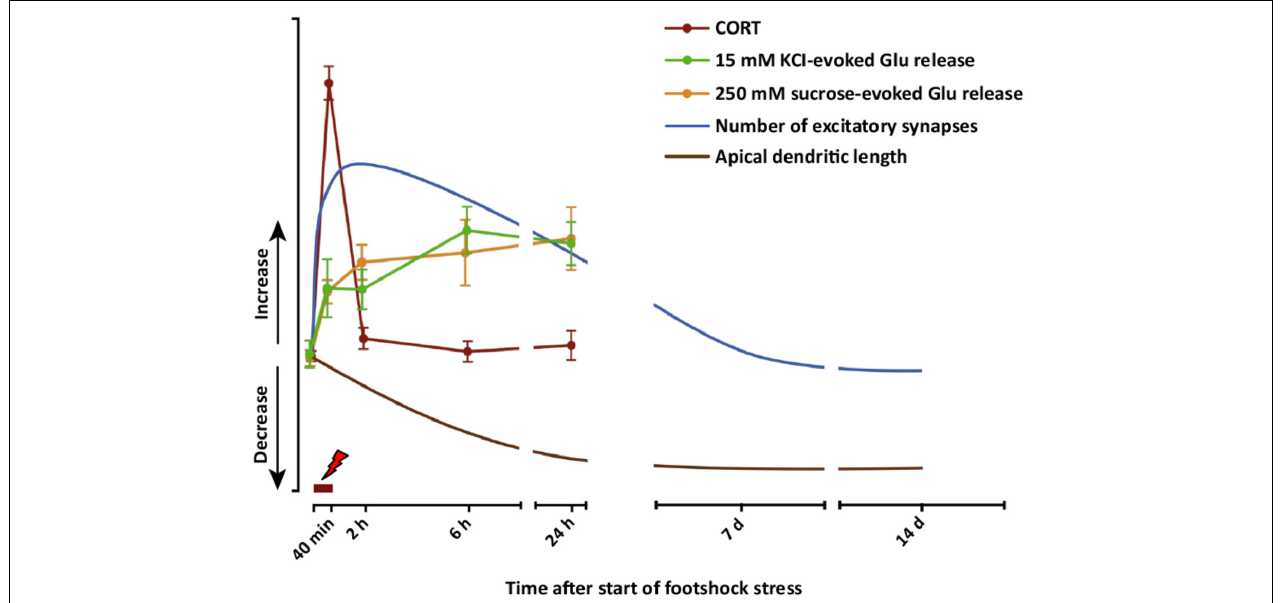
FIGURE 4 | Graphic summary of short- and long-term functional and neuroarchitectural effects in prefrontal cortex (PFC) synapses after acute FS stress. The fast and transient increase in CORT release induced by acute FS stress was accompanied by the rapid increase in both depolarization-evoked and hypertonic sucrose-evoked (RRP) glutamate release in PFC, and the number of small excitatory synapses. The enhancement of glutamate release was sustained for up to 24 h, as well as the increased number of excitatory synapses, which normalized between 24 h and 7 days after FS. Before 24 h had elapsed from the start of FS stress, retraction of apical dendrites began and was sustained for up to 14 days. The timing of actual FS stress (40 min) is indicated by the red mark. Number of excitatory synapses and apical dendrite length are indicative and not in scale with other readouts. From Musazzi et al.